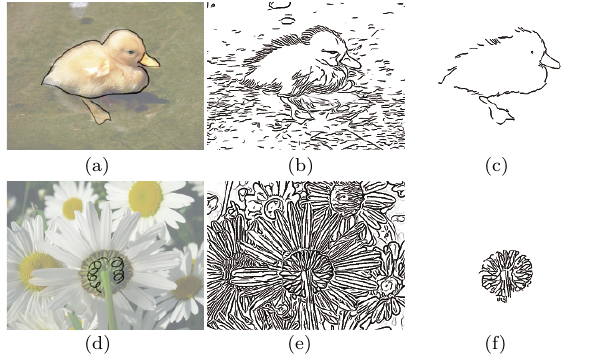
Fig. 14 Limitations. (a, d) Input images with coherence strokes and structure strokes respectively. (b, e) Detailed line drawings of (a, d) respectively. (c, f) Line abstractions produced by our system. Note that (c) fails to extract coherence lines due to the noisy line segments along the duck’s boundary in (b). Due to the small color difference between sepals and flower stem in (d), our system extracts lines from both sepals and stem even though the user is only interested in the sepal